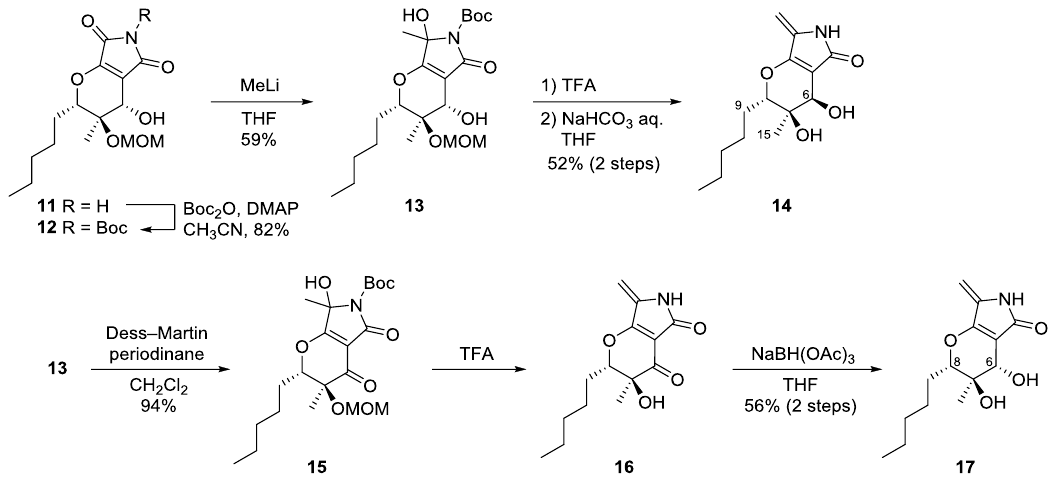
Figure 3. Structural characterization of synthetic compound 17 (* Upper values: PPPC ( 3 ) [1], Lower values: Synthetic 17; Reproduced with permission from [1]).